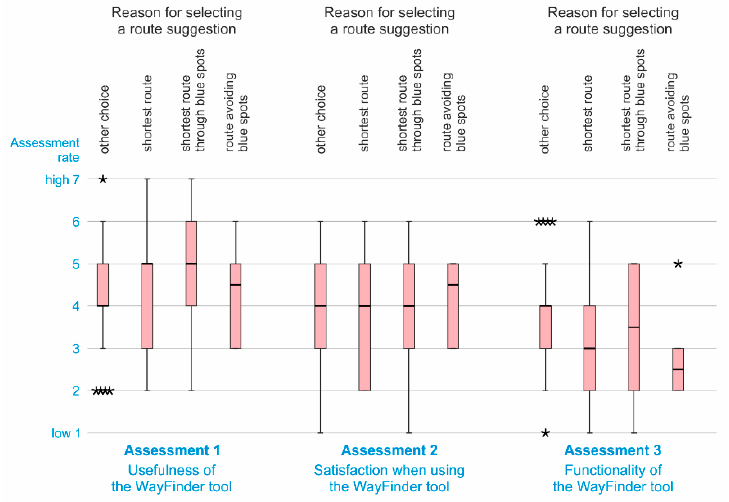
Figure 7. Tool assessments and reasons for selecting a specific route suggestion (asterisks in the box plots show outliers in the datasets).